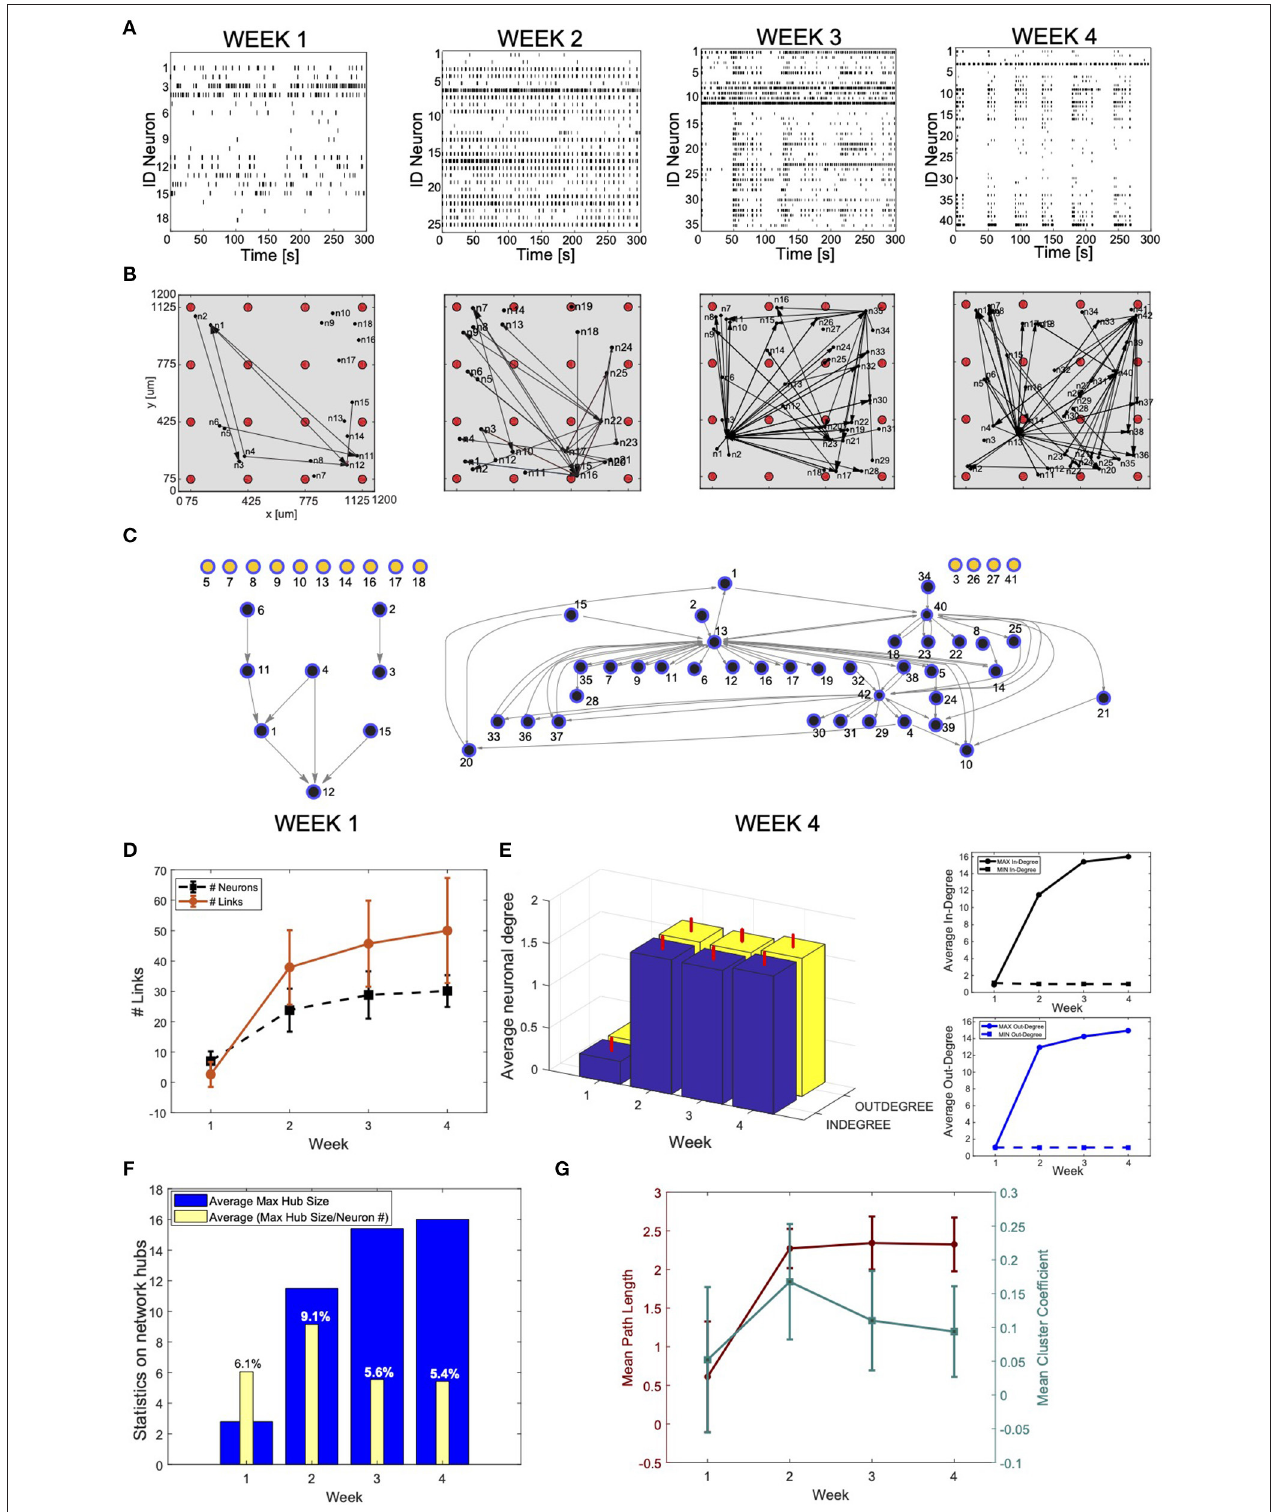
FIGURE 5 | Connectivity reconstruction from neural recordings of developing induced pluripotent stem cells (hiPSC)-derived neurons. (A) Raster plots of the same MEA well at different time points during development: week 1, 2, 3, and 4 after plating. The four panels shows spiking signals from individual neurons (rows)